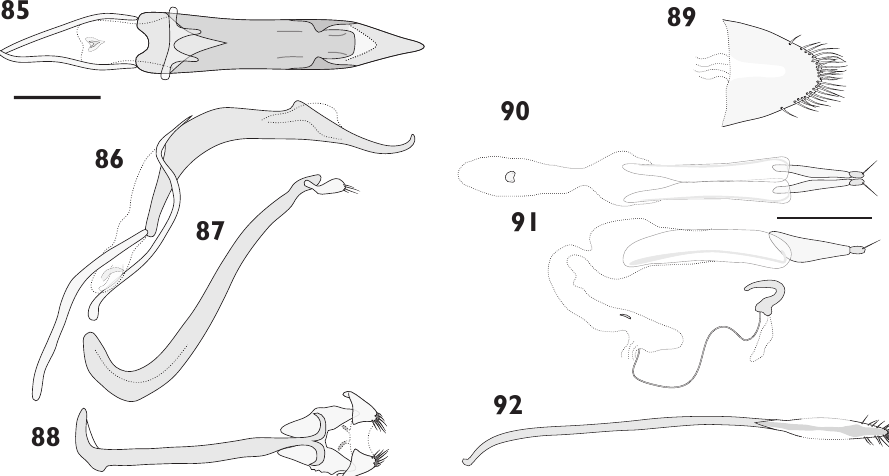
Figures 85–92. Genitalia of Austromonticola mataura . 85 aedeagus, dorsal view 86 aedeagus, lateral view 87 male hemisternites 8 and spiculum gastrale, lateral view (muscles between hemisternites 8 and ba- sal plate indicated) 88 male hemisternites 8 and spiculum gastrale with basal plate, ventral view 89 female tergite 8, dorsal view 90 ovipositor, dorsal view 91 ovipositor and spermatheca, lateral view 92 female sternite 8, ventral view. Scale bars = 0.5 mm; 85–88 at same scale; 89–92 at same scale.